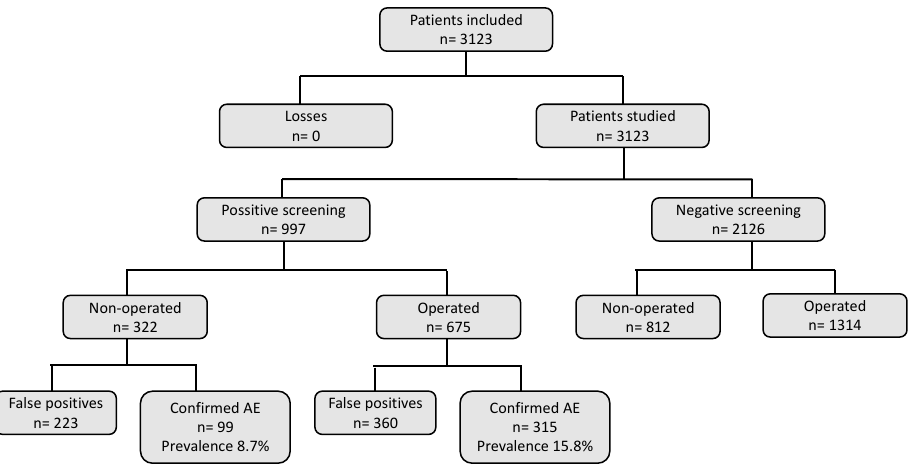
Figure 1. Prevalence of AE in patients seen in surgical services.